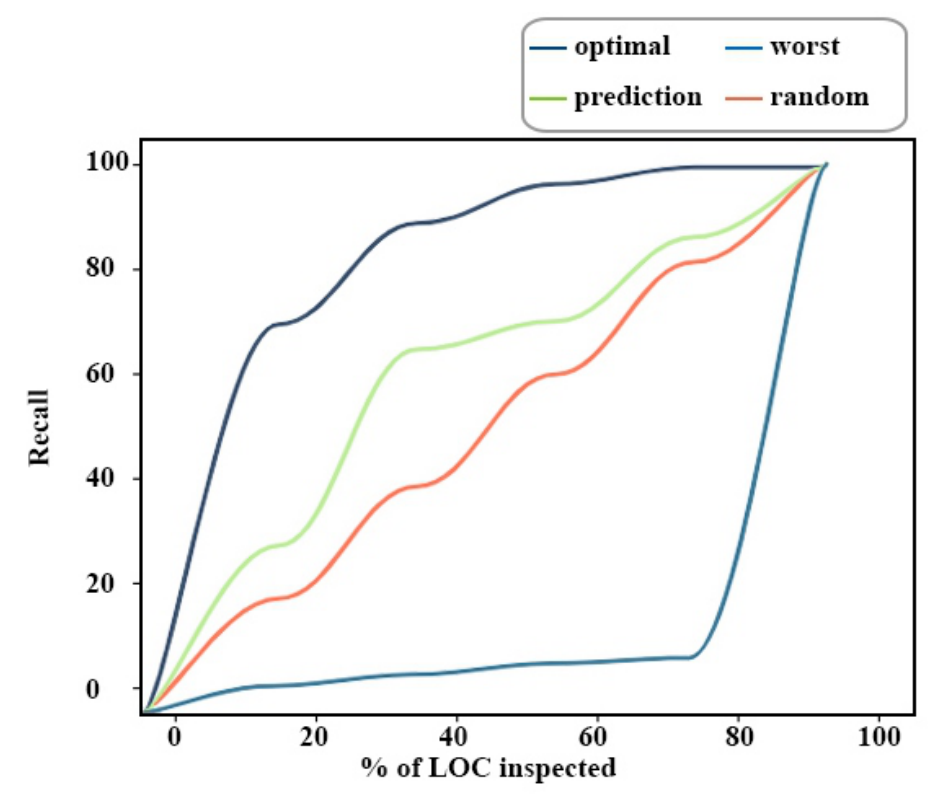
Figure 11. Alberg diagram